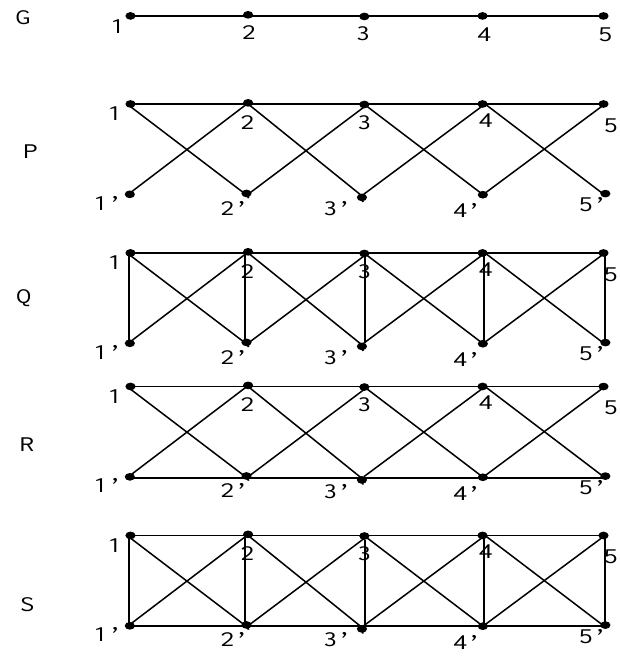
Fig. 3 The graphs G , P = Λ ( G ) , Q = Λ [ G ] , R = D 2 ( G ) and S = D 2 [ G